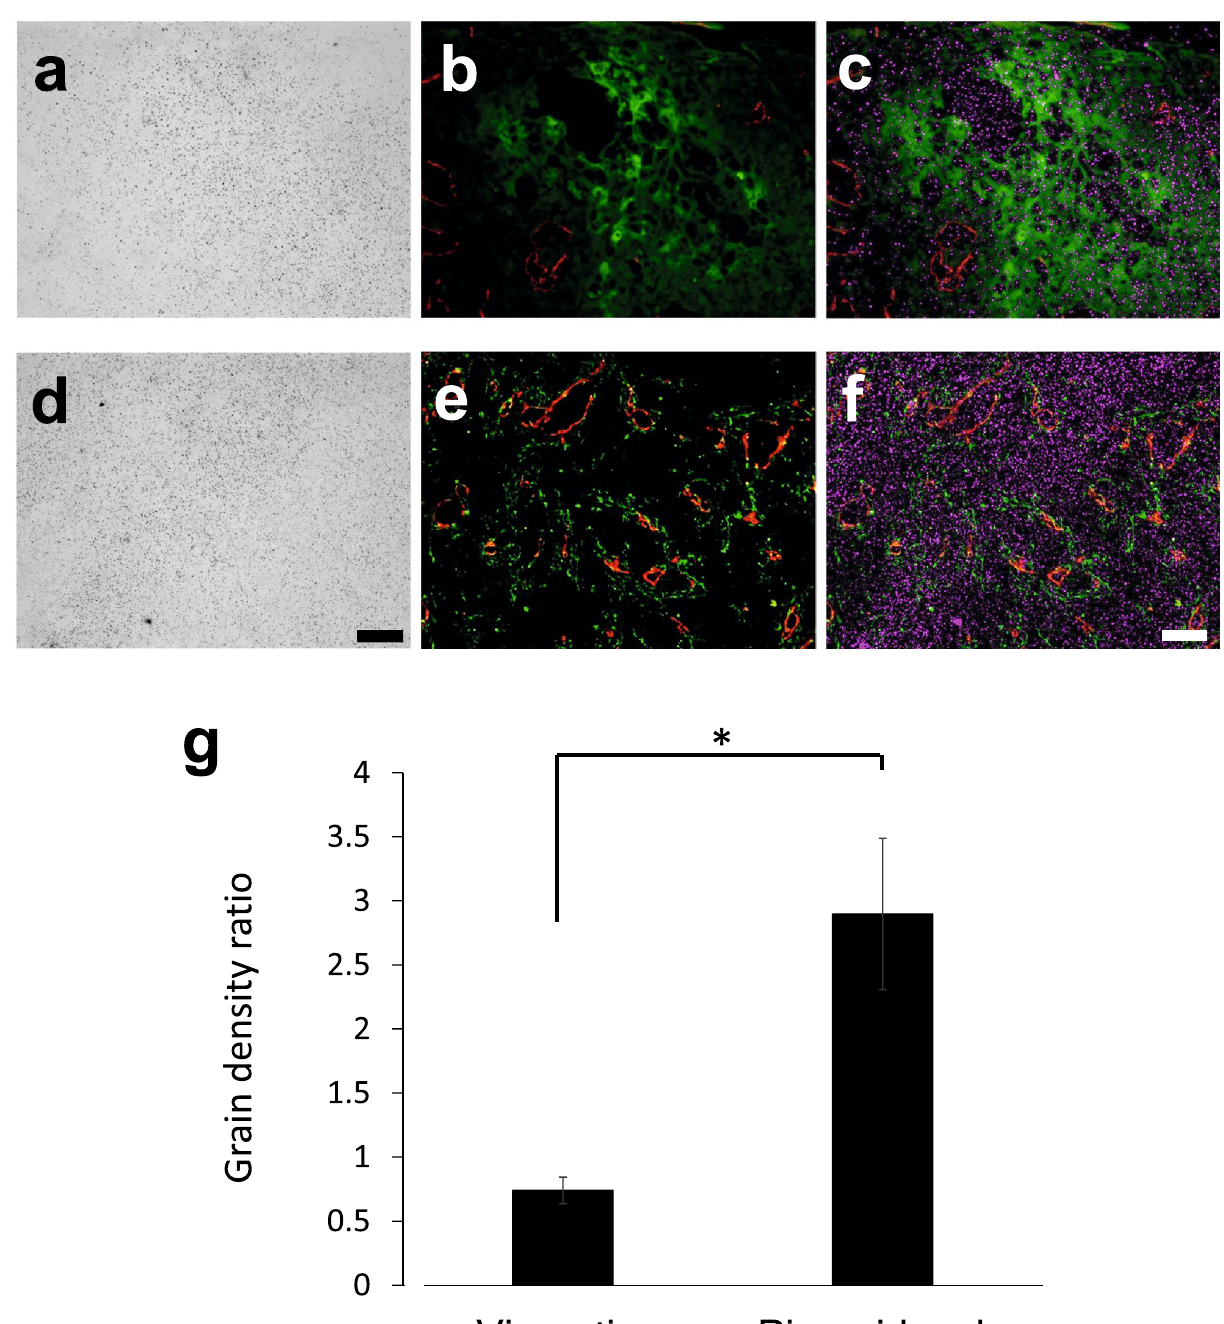
Figure 4. 18 F-FDG accumulation in hypoxic cells and host-derived cells. ( a ) Micro-autoradiography, ( b ) Merged image for pimonidazole (green) and CD31 (red), and ( c ) merged image for pimonidazole (green), CD31 (red), and grains (magenta) in the same view of the A431 cell-derived tumor section. ( d ) Micro- autoradiography, ( e ) Merged image for vimentin (green) and CD31 (red), and ( f ) Merged image for vimentin (green), CD31 (red), and grains (magenta) in the same view. ( g ) Grain density ratio of the pimonidazole- positive region to the CD31-positive region and the vimentin-positive region to the CD31-positive region (n = 3, mean ± SEM, Student’s t -test, two-sided, *: p < 0.05). Bars: 100